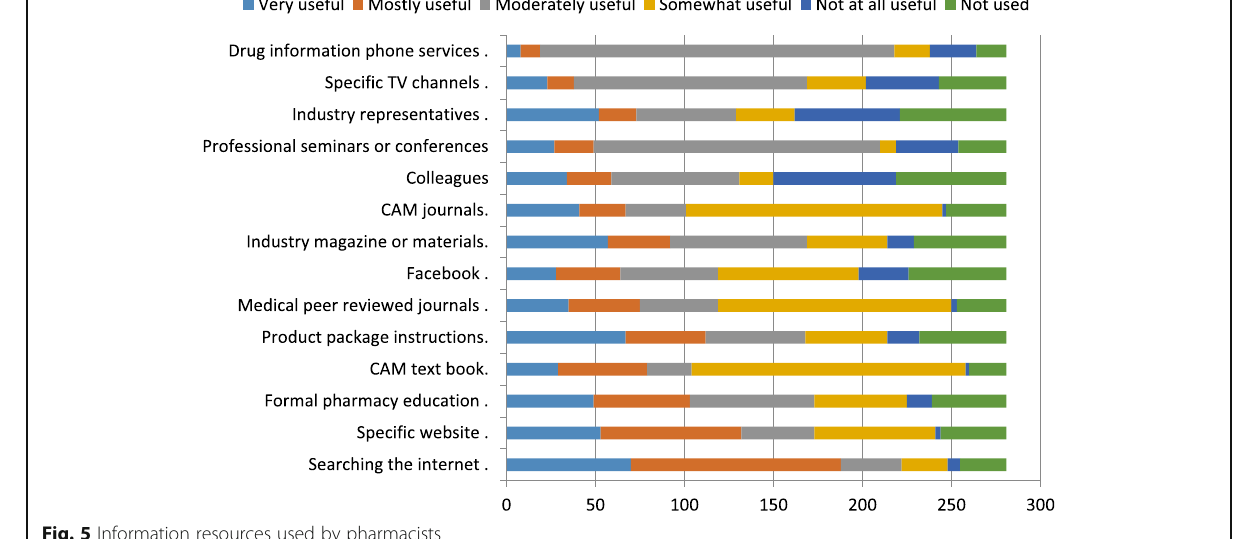
Fig. 5 Information resources used by